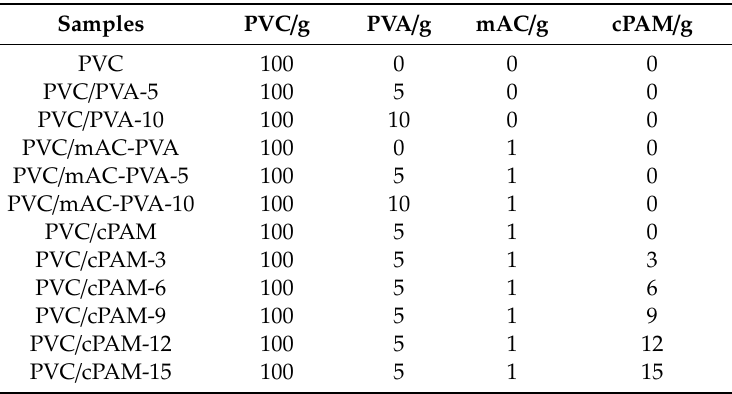
Table 2. The formulation and abbreviation of the